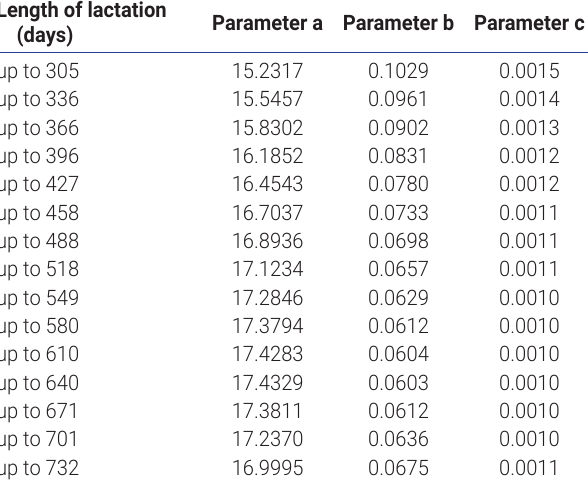
Table 3. The effect of extended lactation on a , b , and c parameters of Wood’s model of lactation curve Length of lactation (days)